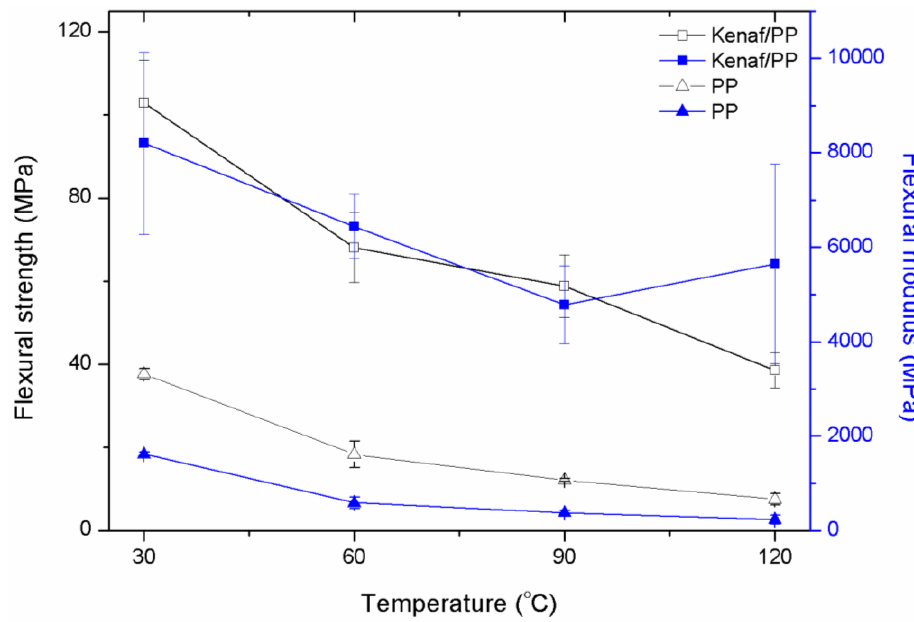
Figure 4. Flexural strength and flexural modulus of kenaf/PP composites at different temperatures.